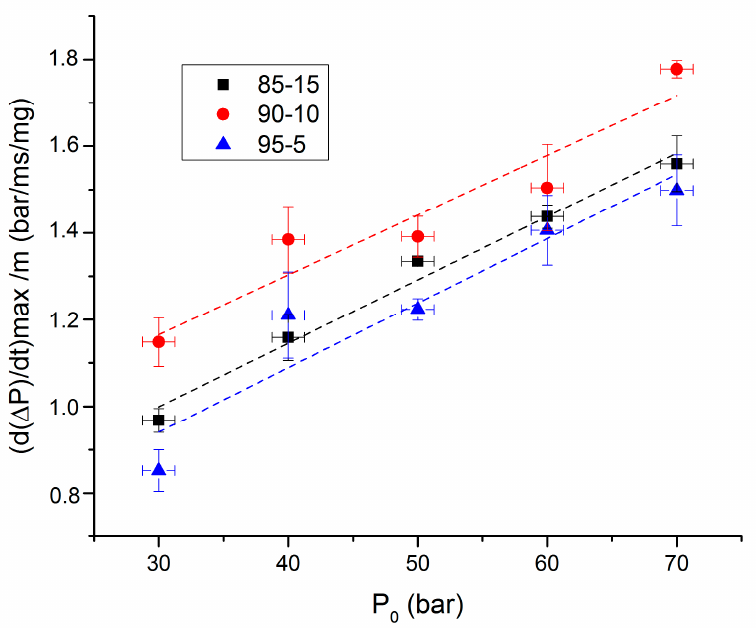
Figure 8. Propagation rates as functions of initial pressures under argon.